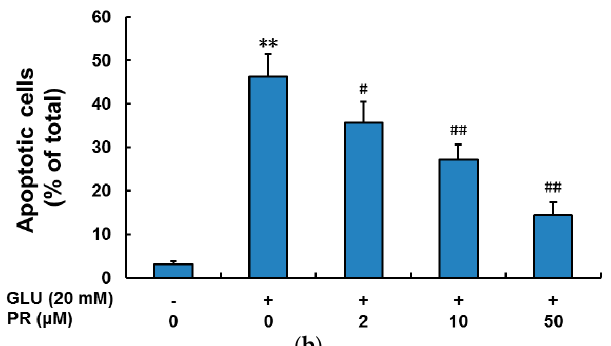
Figure 4. The neuroprotective effect of puerarin against glutamate-induced apoptosis in the differentiated Y-79 cells. Cells were pre-treated with puerarin (0, 2, 10 and 50 μ M) for 24 h and then exposed to 20 mM glutamate for 24 h. After treatment, cells were re-suspended in 300 μ L binding buffer containing 10 μ L of Annexin V-FITC stock and 10 μ L of propidium iodide (PI), and then incubated at room temperature for 15 min in the dark. ( a ) Flow cytometry analysis of cell apoptosis using Annexin V-FITC/PI dual-staining; ( b ) the densitometric analysis of the percentage of apoptotic cells. All data were expressed as mean ± SD of three experiments and each experiment included triplicate repeats. ** p < 0.01 vs. control group; # p < 0.05, ## p < 0.01 vs. glutamate-treated group. GLU: glutamate, PR: puerarin.